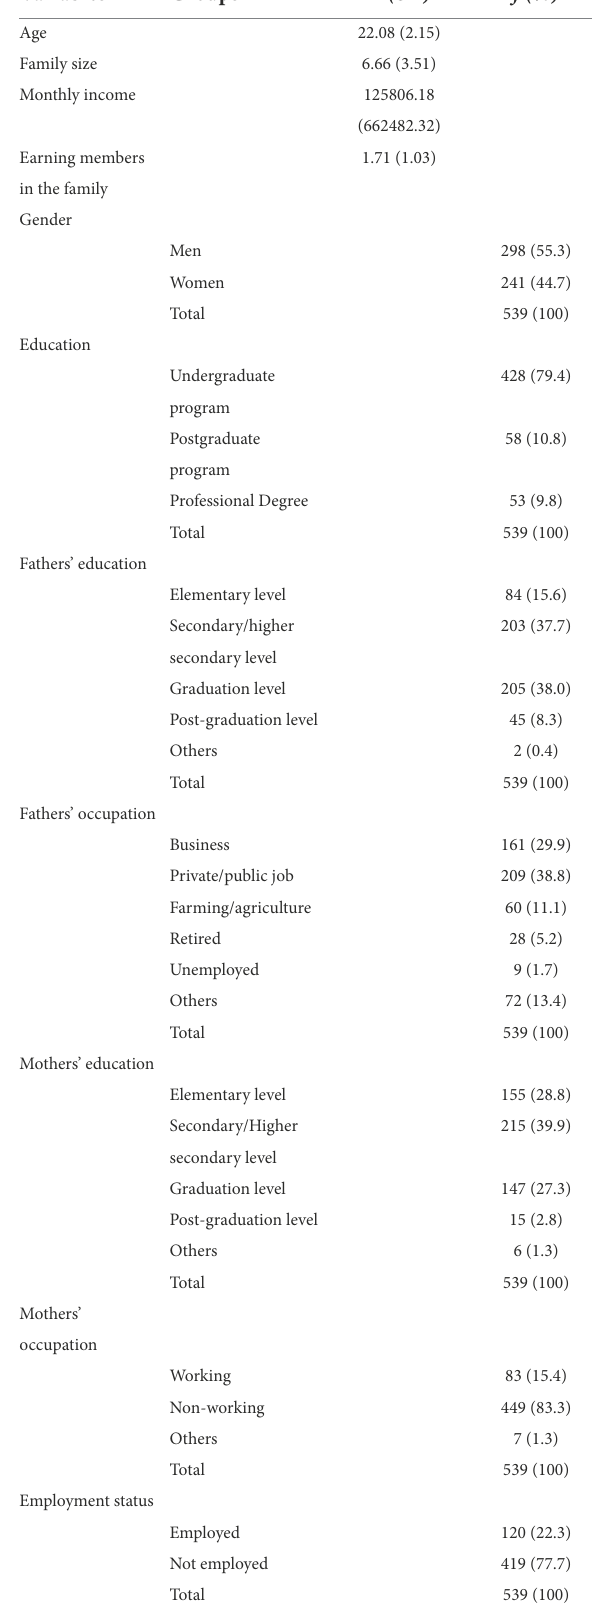
TABLE 1 Socio-demographic characteristics of the study